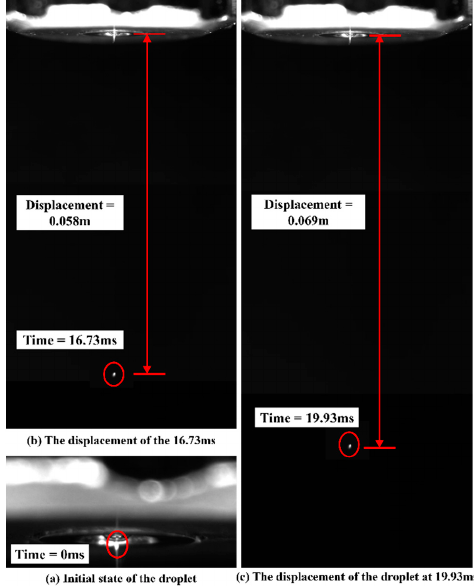
Figure 10. Displacement of the second group of experiments at different moments. ( a ) initial state of the droplet, ( b ) the displacement of the 16.73 ms, ( c ) the displacement of the droplet at 19.93 ms.